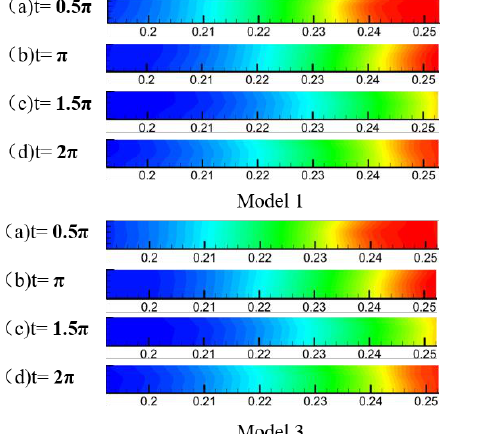
Figure 7. Pulse tube vorticity cloud.